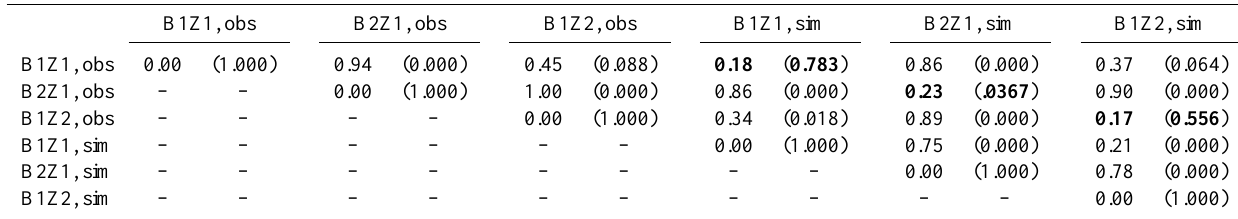
Table 8. Kolmogorov–Smirnov test statistic to compare distributions of the annual maximum flows (m 3 s − 1 ).